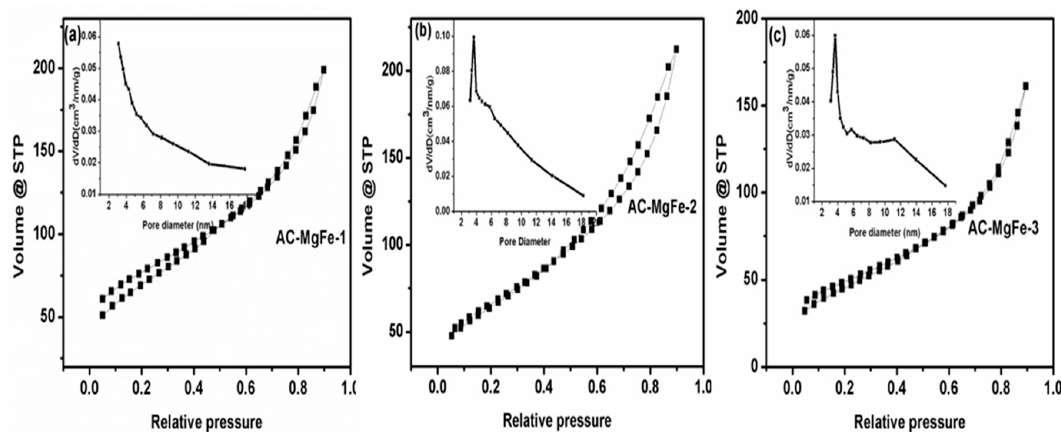
Figure 3. N 2 adsorption/desorption for ( a ) AC-MgFe-1 ( b ) AC-MgFe-2 and ( c ) AC-MgFe-3 AC–MgFe